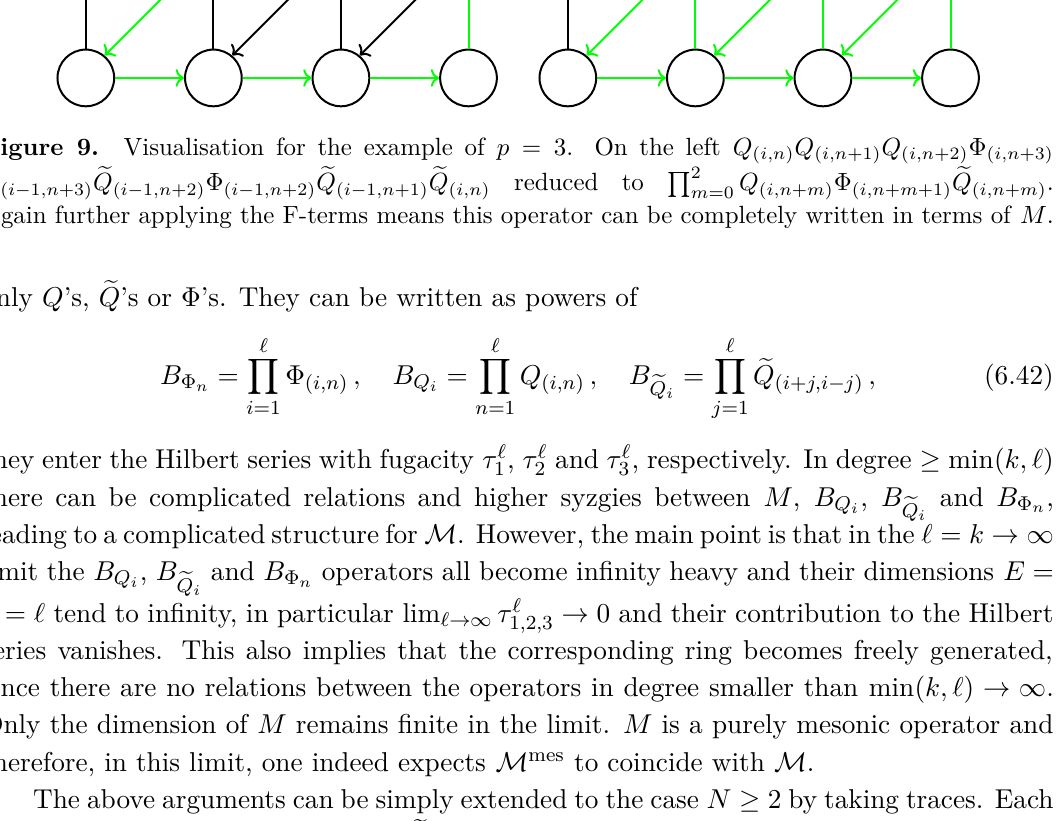
Φ Q Q ( i,n ) ( i,n +1) ( i,n +2) ( i,n +3) Φ . Q Q ( i,n + m ) ( i,n + m +1) e ( i,n + m ) m =0